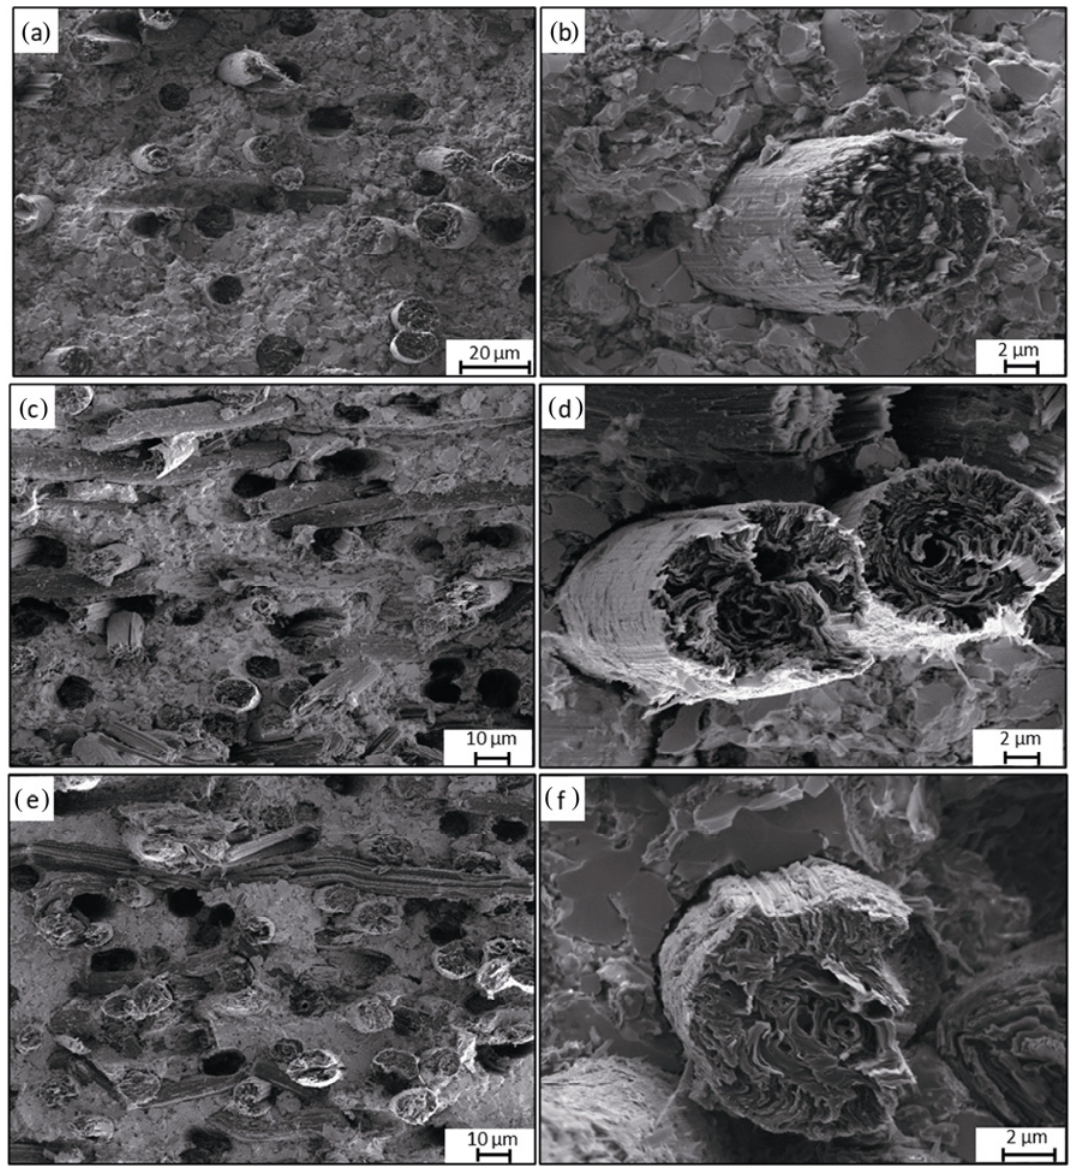
Fig. 9 (a, b) Fracture surfaces of samples with 20 vol%–3 mm C f after bending test; (c, d) fracture surfaces of samples with 35 vol%–3 mm C f after bending test; and (e, f) fracture surfaces of samples with 50 vol%–3 mm C f after bending